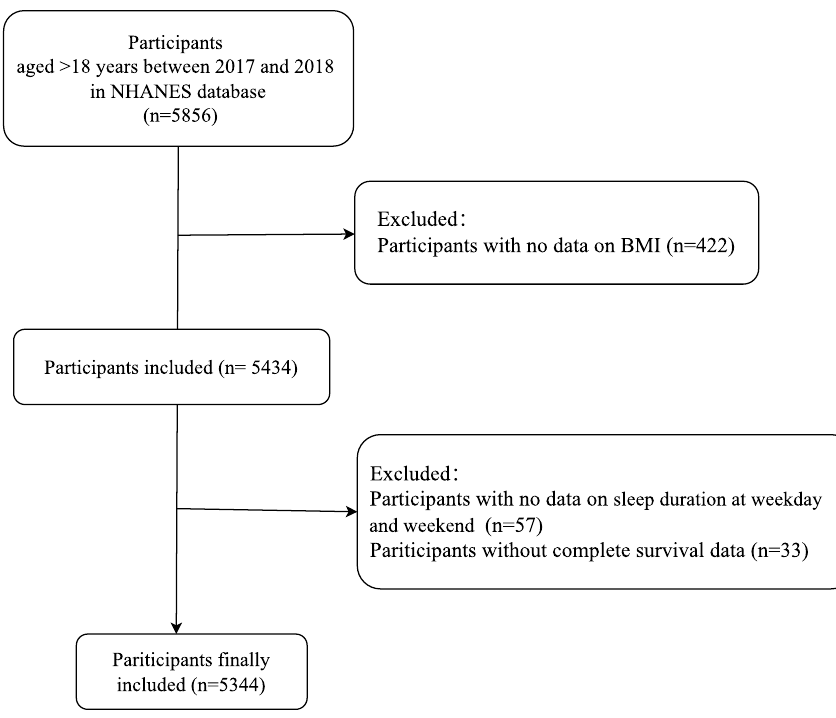
Fig. 1 The screening process of participants in this